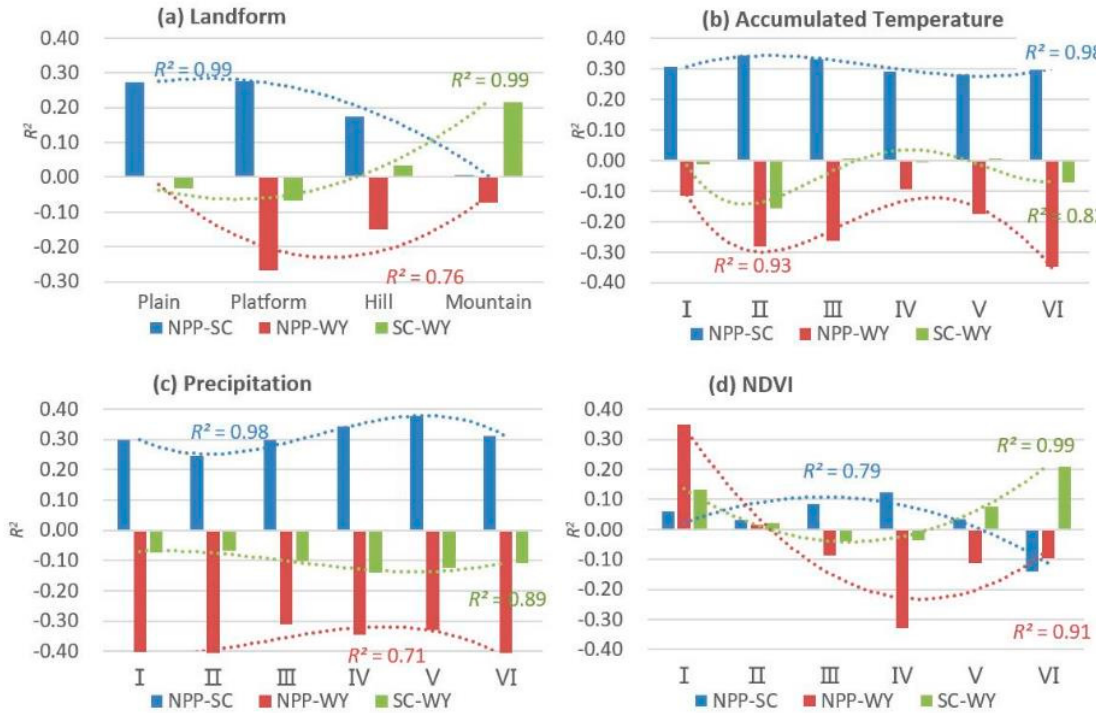
Figure 7. Trade-o ff s/synergies among three ecosystem services under di ff erent in fl uencing factors in Jiangxi Province: ( a ) landform; ( b ) ≥ 10 °C active accumulated temperature; ( c ) precipitation; ( d ) NDVI. I to VI are the areas divided by natural breakpoint method based on the value of in fl uencing factors.